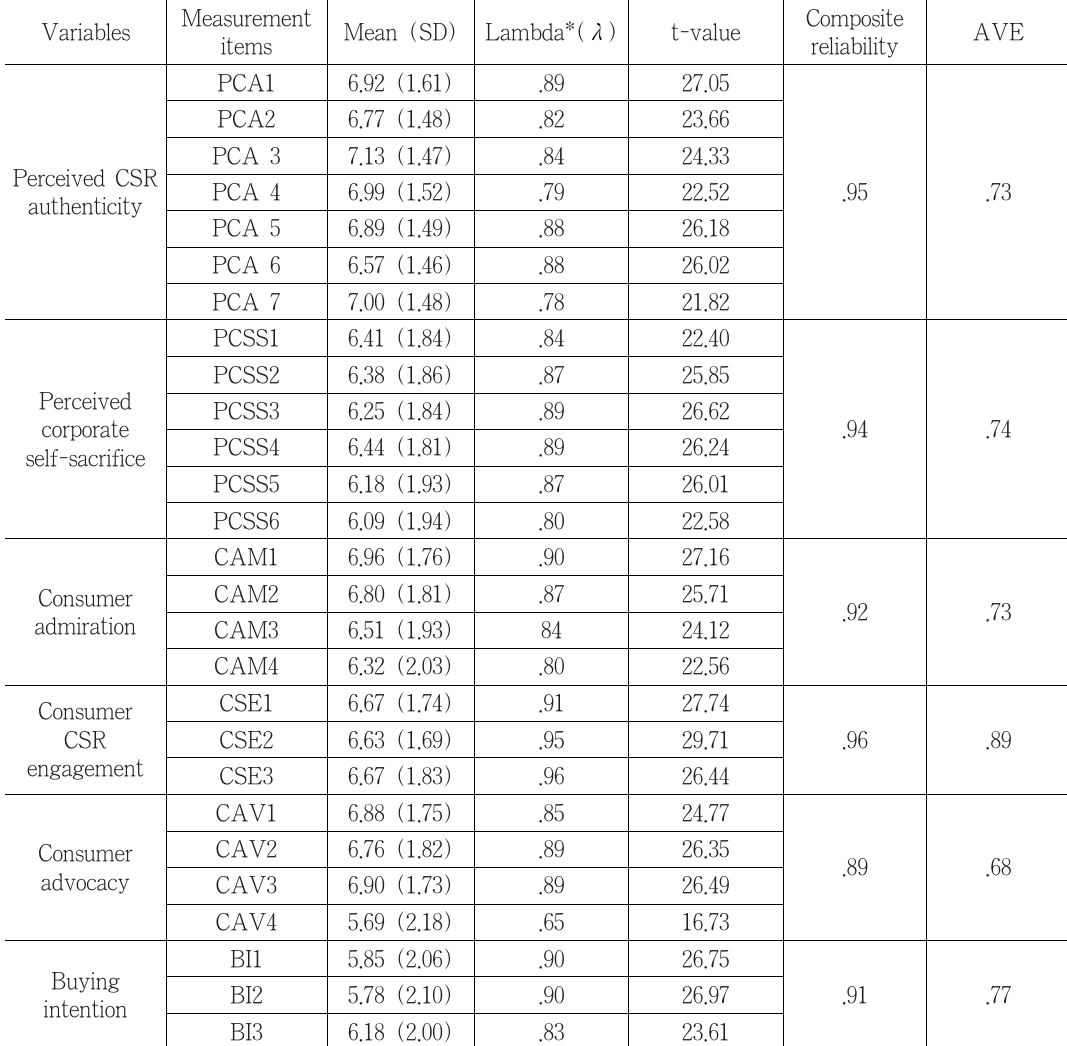
<Table 2> Summary of Measurement